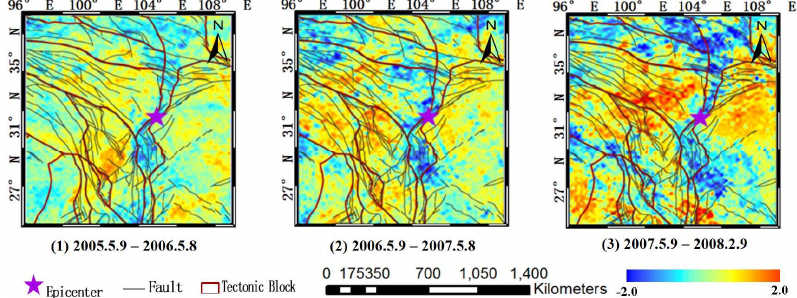
Figure 8. TIR anomalies prior to the Wenchuan earthquake event in different periods.